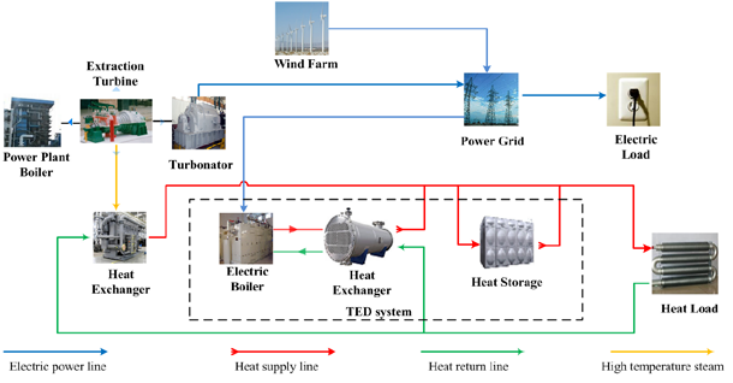
Figure 3. Schematic diagram of the thermal-electric decoupling